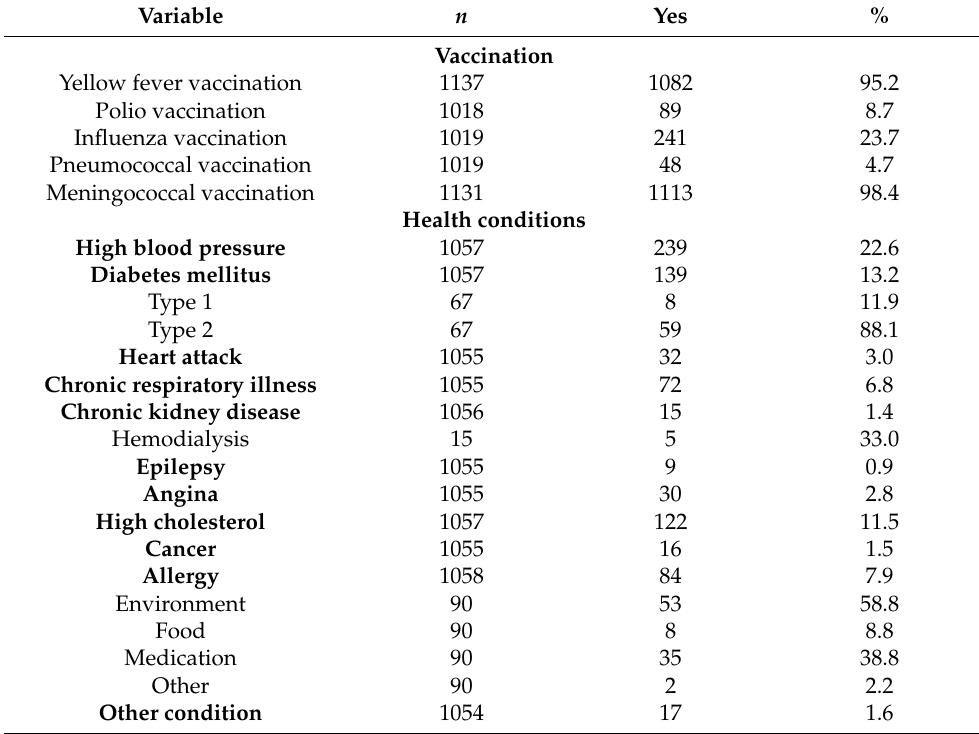
Table 2. Vaccination and underlying health conditions among enrolled